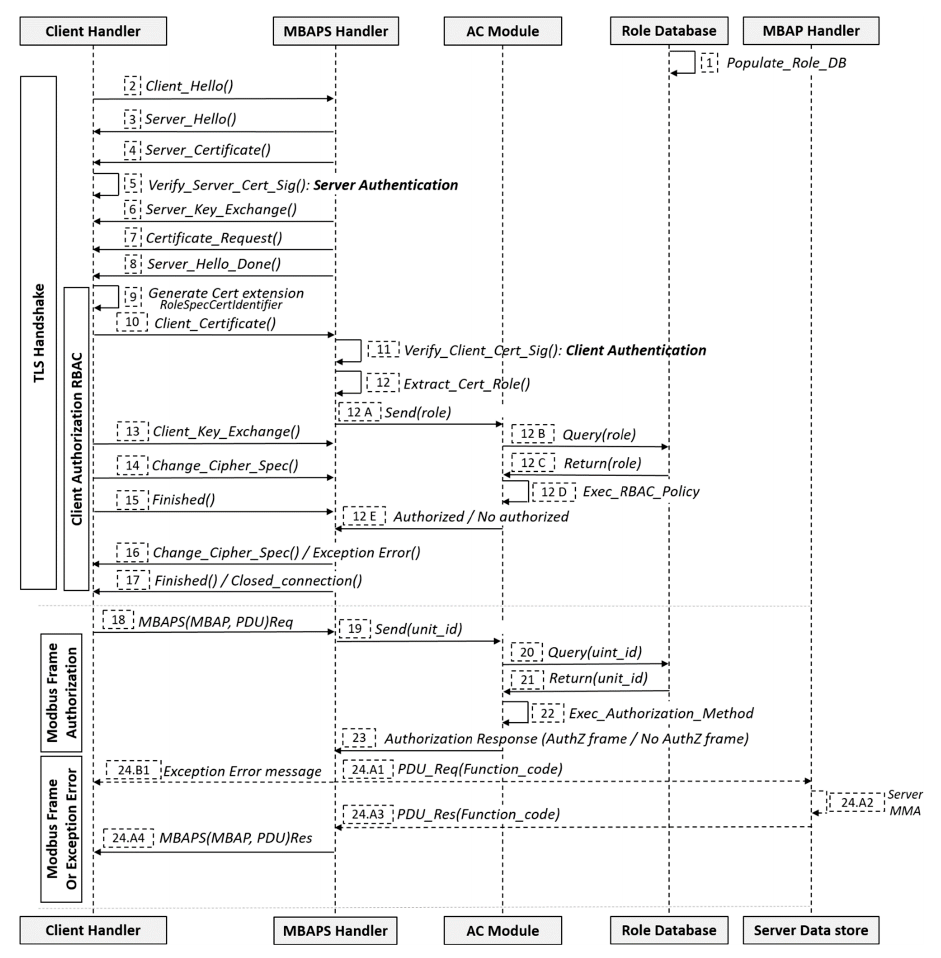
Figure 5. Sequence Diagram of Modbus Transport Layer Security (TLS) handshake and RBAC client authorization.